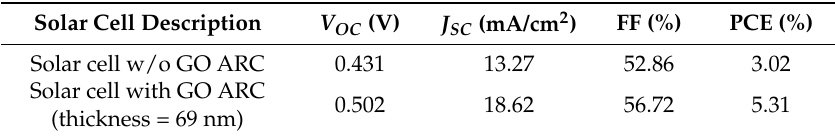
Table 4. Performance of the solar cell with and without the GO quarter-wave anti-reflection coating (ARC).